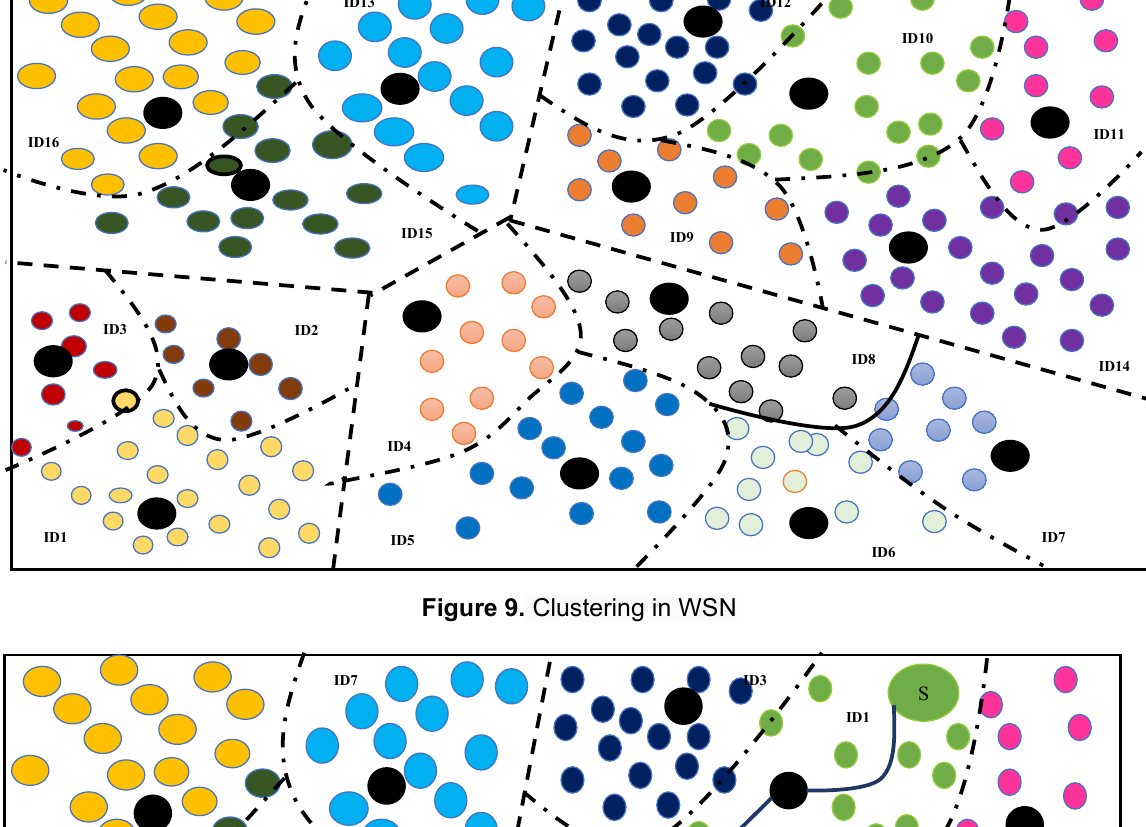
Figure 9. Clustering in WSN